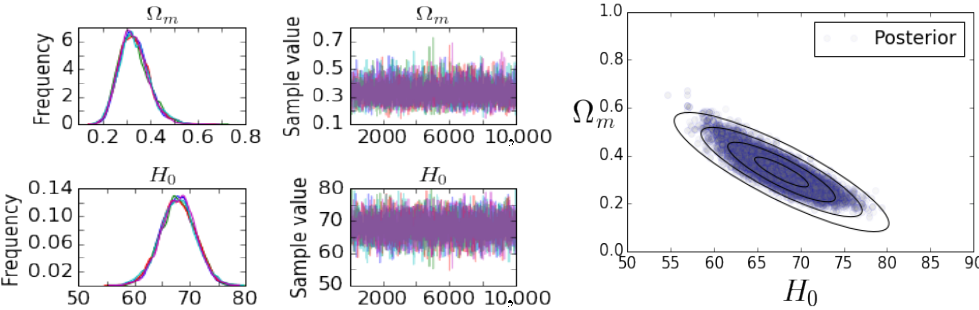
Figure 16. Results for the Λ CDM model. Left panel: One-dimensional posterior distributions for the parameters H 0 and Ω m , along with its chains. Right panel: Joint 2D posterior distributions with 1–4 confidence